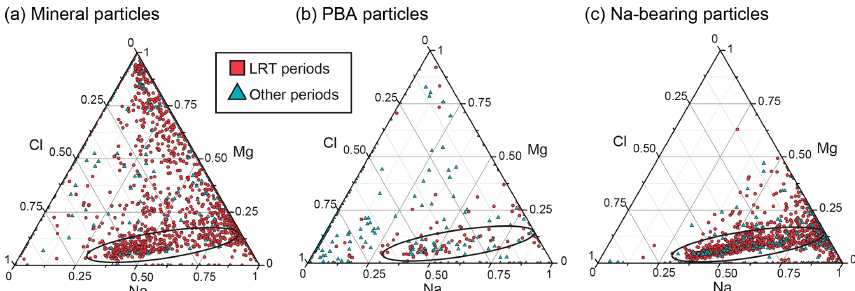
Figure 10. Weight percent ratios among Na, Mg, and Cl within (a) mineral particles, (b) PBA particles, and (c) Na-bearing particles. The black elliptical areas indicate typical sea-salt compositions from a marine